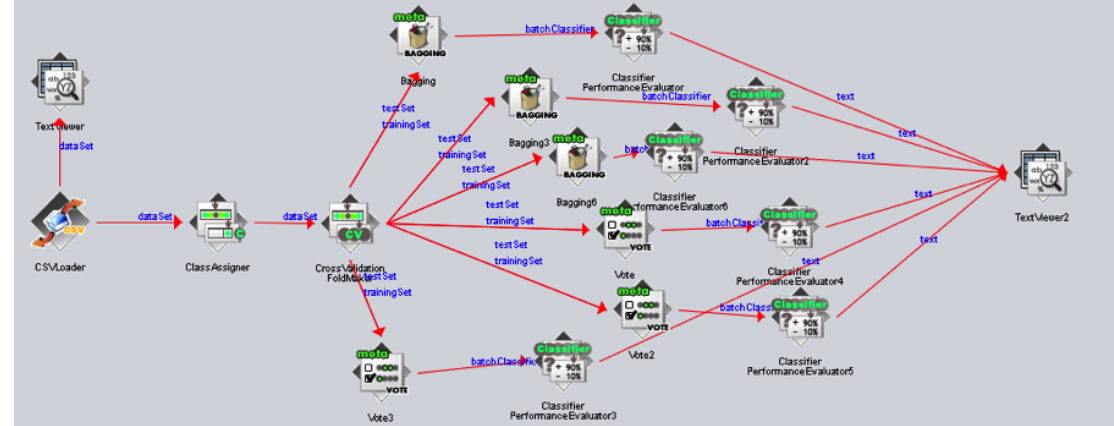
Figure 9. Ensemble method (bagging) implementation using WEKA.